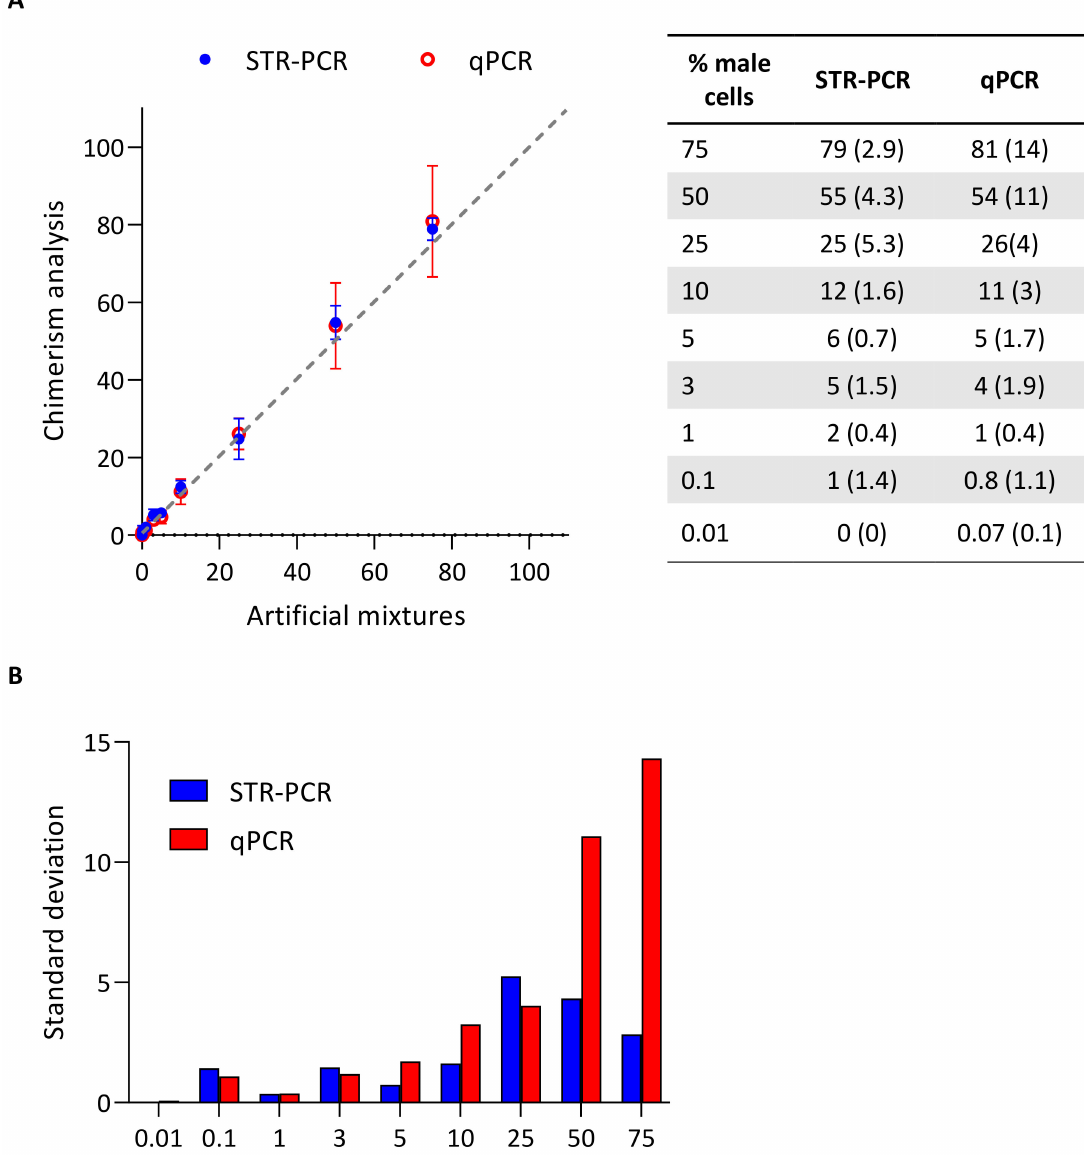
Figure 2. Artificial mixture analysis. ( A ) Results of chimerism quantification using STR-PCR (blue) and qPCR (red), versus actual percentage of cells of putative recipient (male). Results are represented as mean and standard deviation (SD, in brackets) of di ff erent independent experiments (n = 2 for STR-PCR, and n = 3 for qPCR). A representation using a logarithmic scale in the x and y axes is provided in Supplementary Figure S1, in order to better discriminate di ff erences in values below 10%, which are clinically less significant. ( B ) Standard deviation of both techniques by percentage of recipient